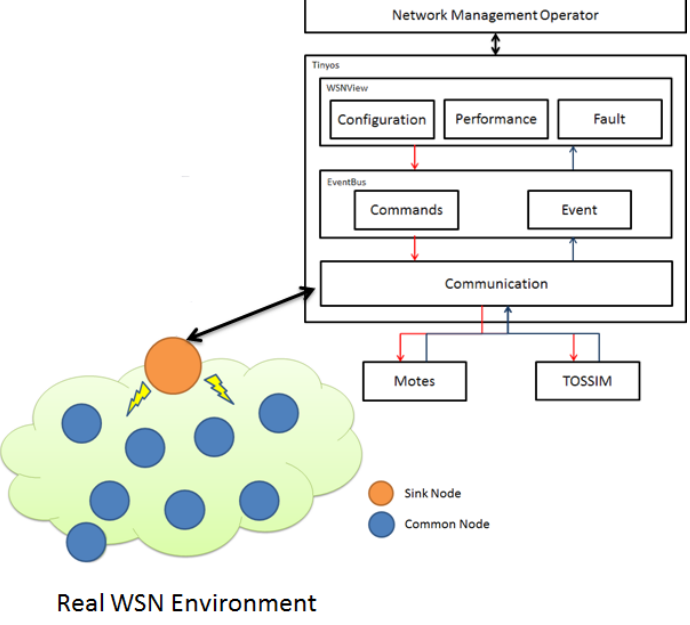
Figure 10. Integrated Real Environment and WSNmanagement